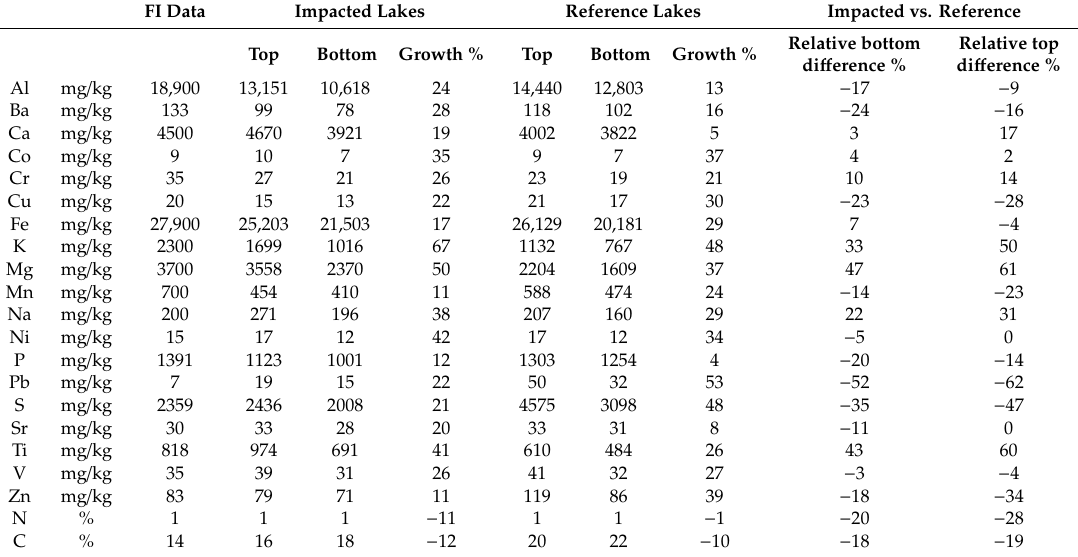
Table 5. Averages for the small lakes from selected Mäkinen & Pajunen Finland (FI) [21] data, the impacted (top and bottom) and reference lakes (top and bottom), temporal changes and their relative di ff erences (if the value is negative, the average is higher in the reference